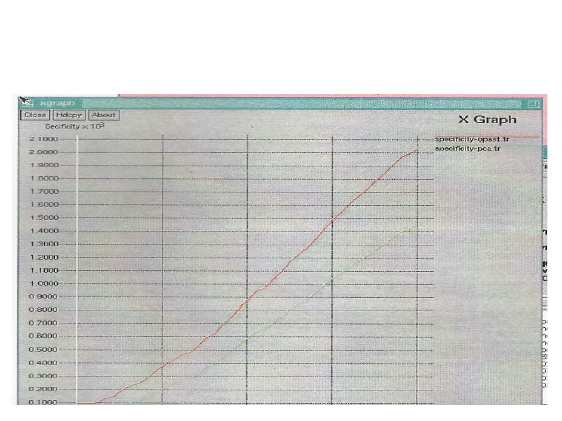
Figure 8. Comparison of Various Nodes